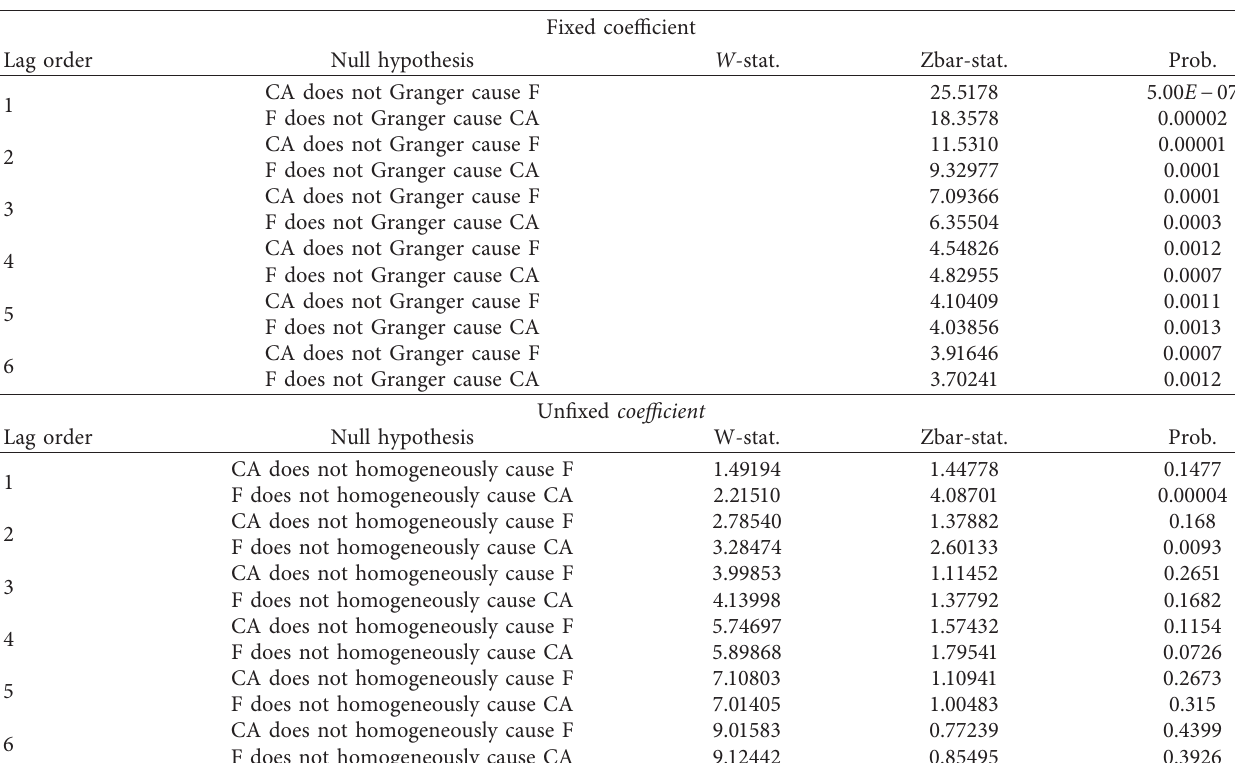
Table 5: Results of Granger’s causality test.